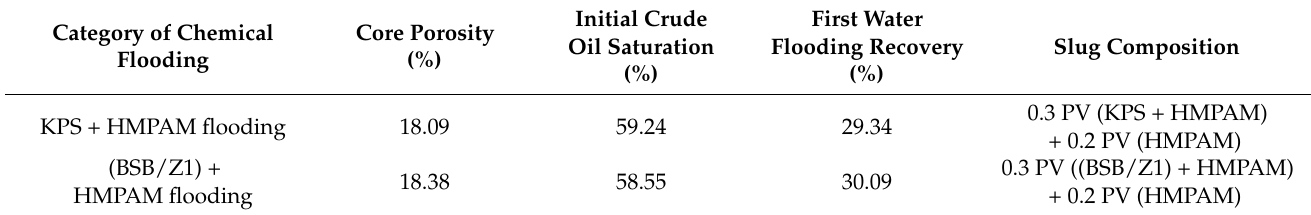
Table 3. The composition of the chemical